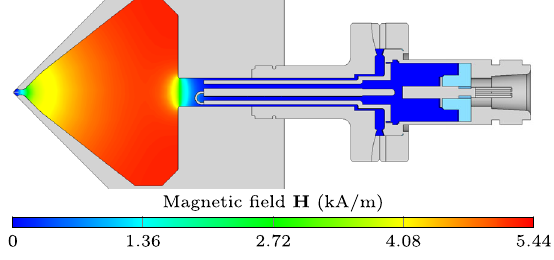
FIG. 9. Magnetic field at the pick-up antenna up to the ceramic rf window. The coupling is very low since the antenna is designed for a power of only 1 W.